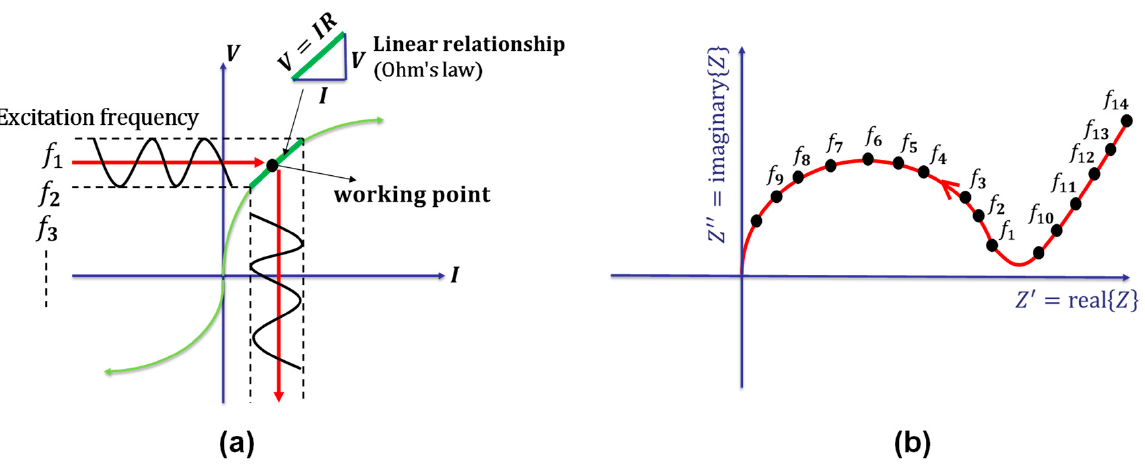
Figure 9. Fundamentals of impedance spectroscopy: ( a ) the voltage-current relationship; ( b ) a complex plane (the Nyquist plot) [148]. ACIS can be used to analyse a simple AC circuit with a resistor, a capacitor, and an (v(t)= v 0 sin ( wt ) ).